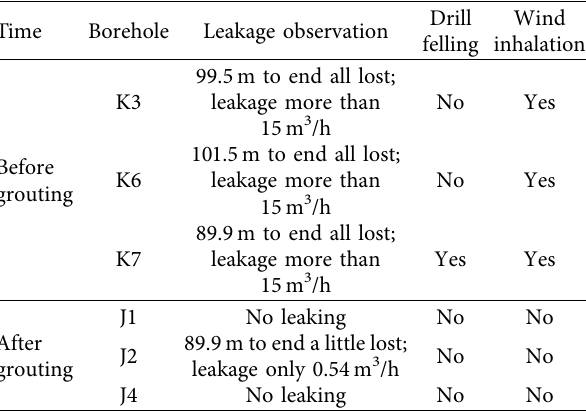
Table 6: Characteristics of the boreholes before and after grouting.